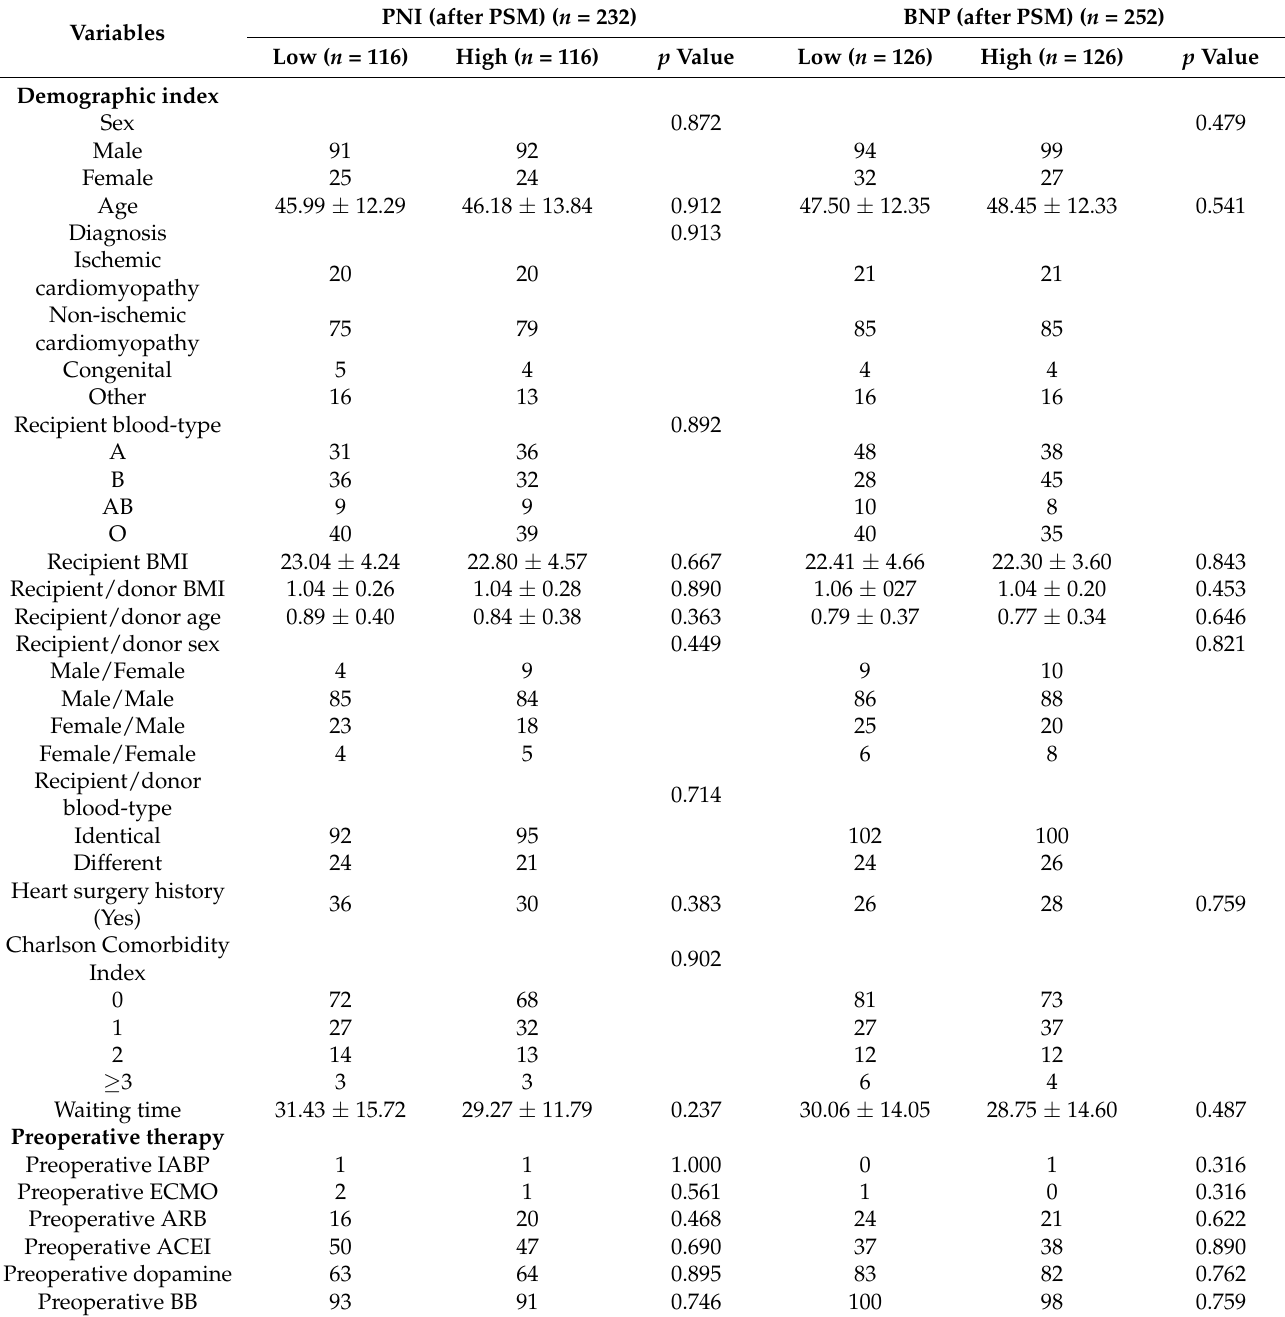
Table 3. Propensity score matching analysis of patients with heart transplantation based on PNI and